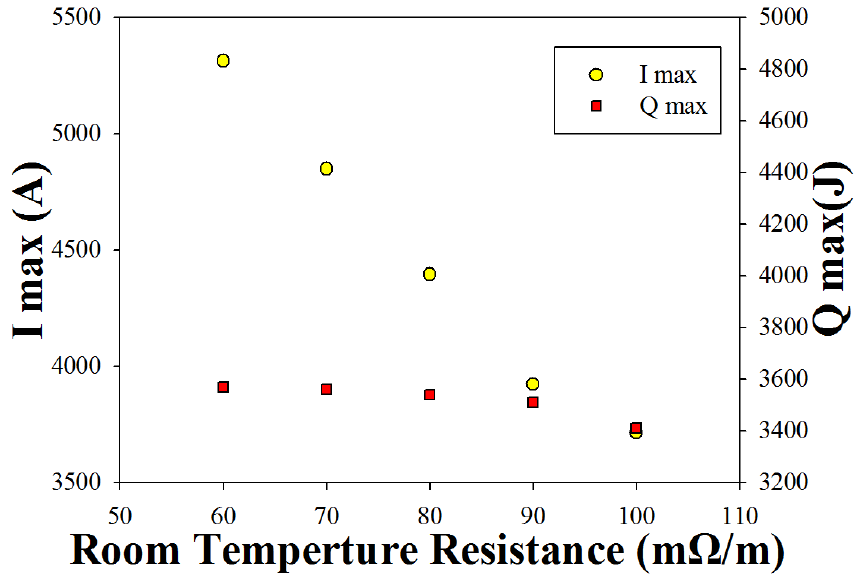
Figure 11. Impact tolerance performance of samples 4–8.